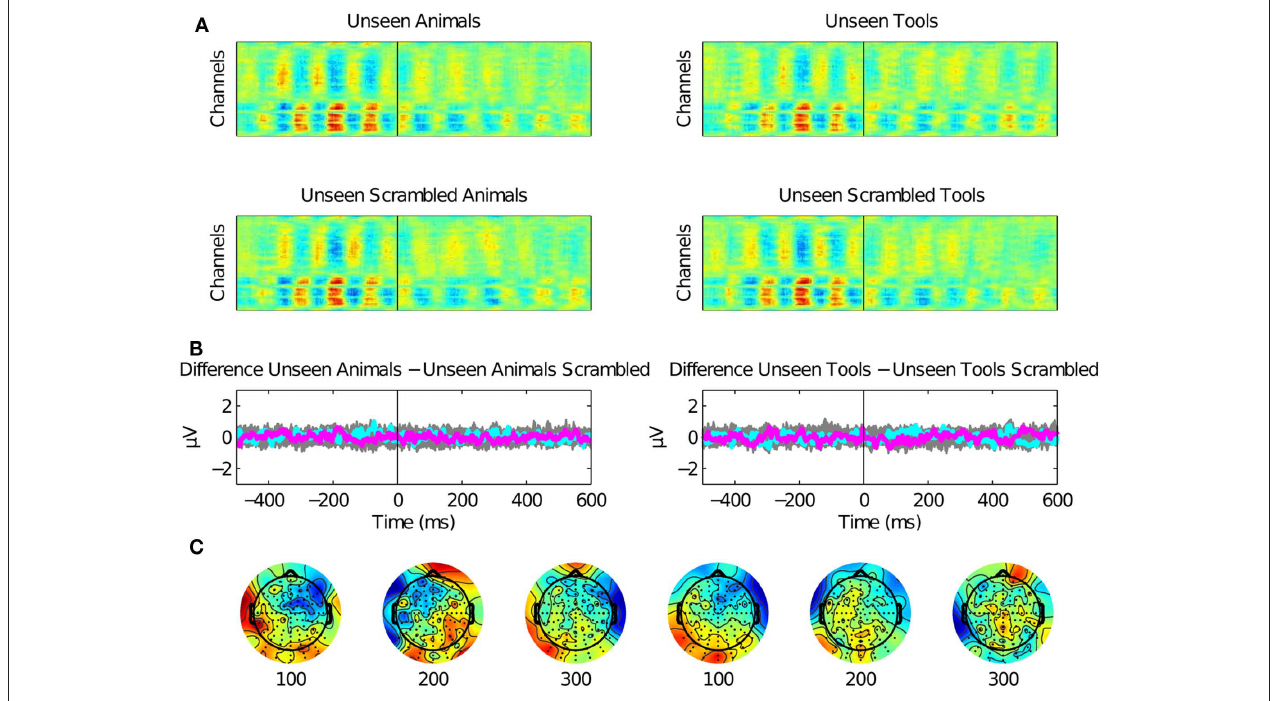
versus unseen scrambled tools are plotted for all channels (gray) and as particular examples for channel “OZ = cyan” and “FZ = magenta.” The activity of Mondrians is canceled by the subtraction between conditions. (C) Topographical maps show no particular information regarding unseen stimuli. CFS eliminated even the earliest EEG correlates of